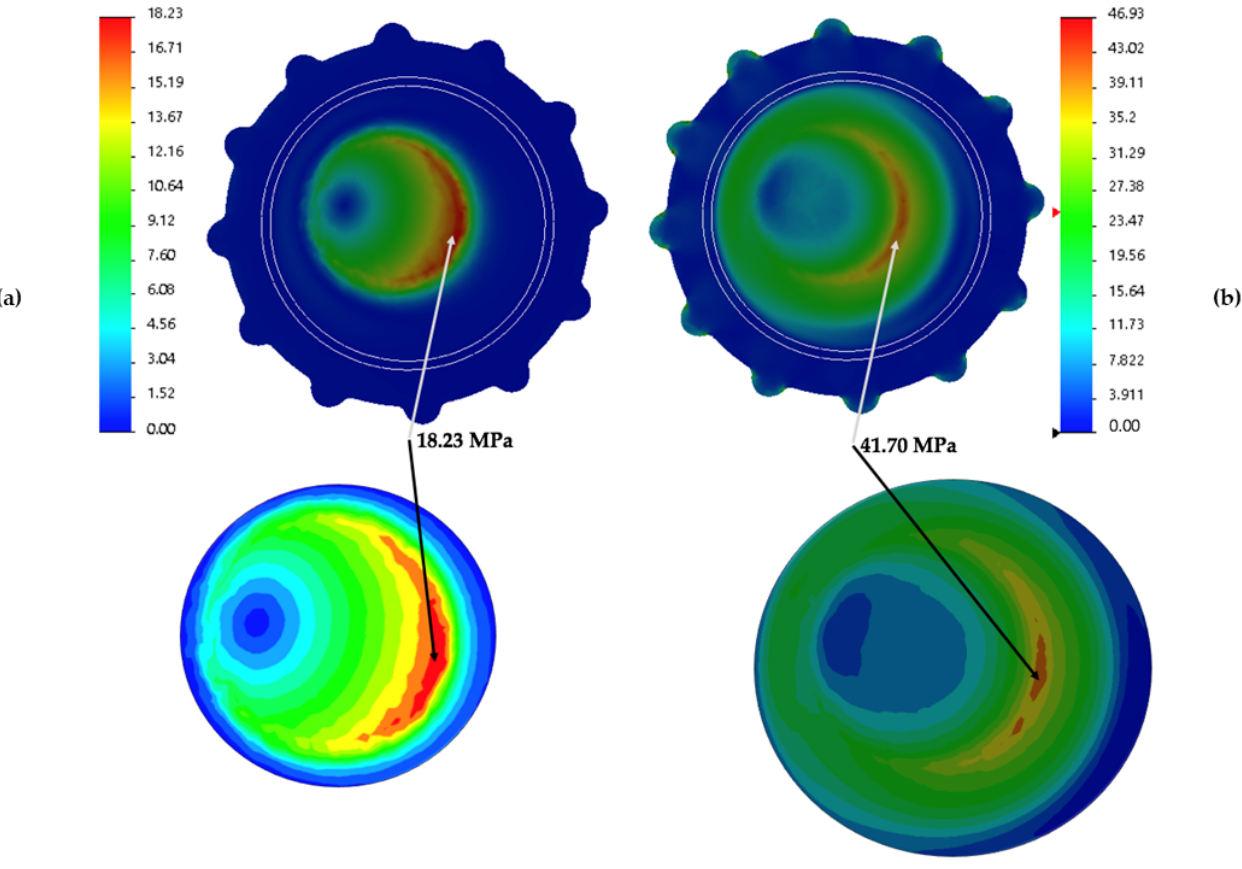
Figure 8. FEA results in images; ( a ) VM Stress cemented fixation of the inner liner surface; ( b ) VM Stress uncemented fixation of the inner liner surface.